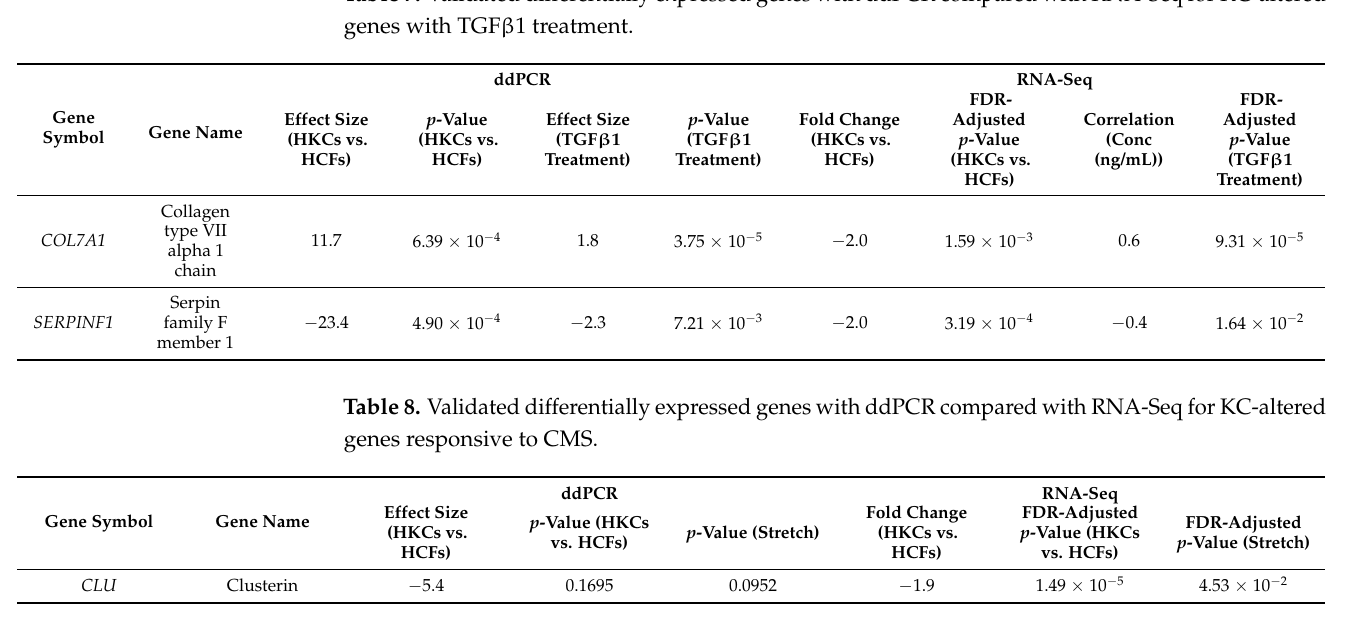
Table 9. Validated differentially expressed genes with ddPCR compared with RNA-Seq for KC-altered genes responsive to TGF β 1 treatment and